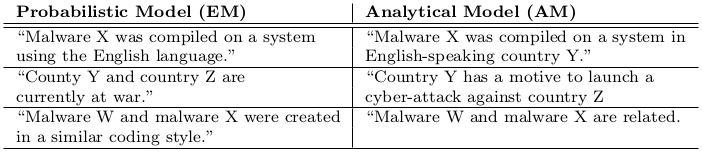
Table from the paper: Belief Revision in Structured Probabilistic Argumentation
Table text:
ProbabilisticModel(EM)
AnalyticalModel(AM)
“MalwareXwascompiledonasystem
“MalwareXwascompiledonasystemin
usingtheEnglishlanguage.”
English-speakingcountryY.”
“CountyYandcountryZare
“CountryYhasamotivetolauncha
currentlyatwar.”
cyber-attackagainstcountryZ
“MalwareWandmalwareXwerecreated
“MalwareWandmalwareXarerelated.
inasimilarcodingstyle.”